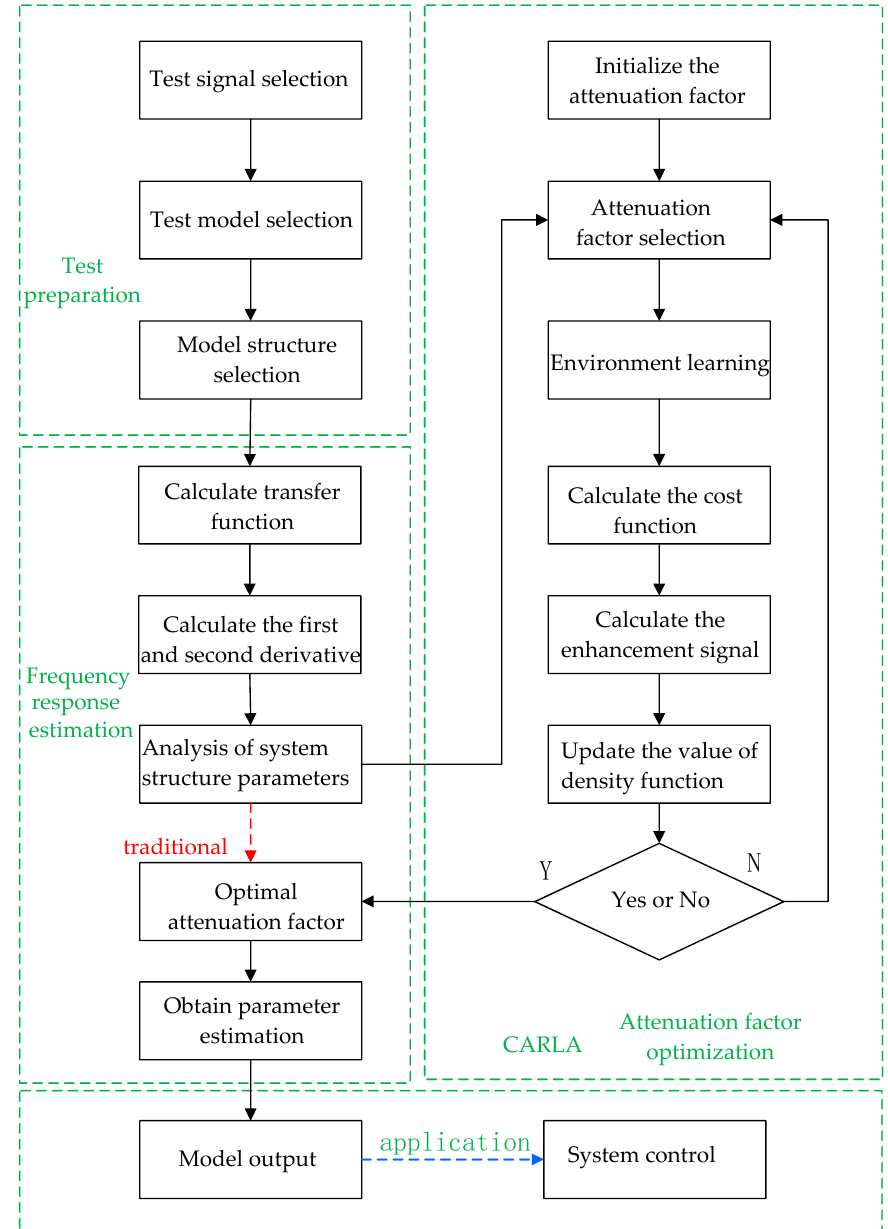
Figure 2. Frequency response estimation method based on continuous action reinforcement learning automata (CARLA-FRE) flow chart.